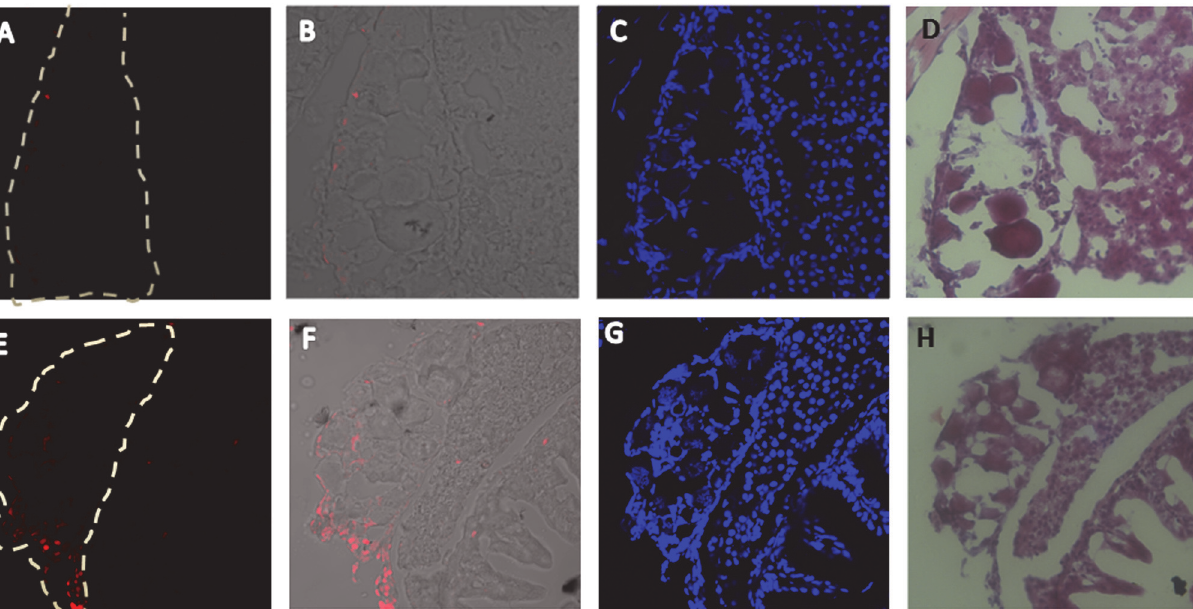
Fig 5. Induced cell death in transition gonads of the dnd :NTR-EGFP transgenic fish via MTZ treatments. The MTZ-induced cell death were evaluated by an in situ cell death assay in the transition gonads of the dnd :NTR-EGFP transgenic fish at 26 dpf stage after 1 week MTZ treatment. Transgenic fish at 18 dpf were treated with 5 mM MTZ/0.2% DMSO or 0.2% DMSO solution for 1 week. The fish were cryosectioned at 6 μ m for in situ TUNEL assay. A-D) transition gonad after MTZ treatments with apoptosis signals under fluorescent microscope (red fluorescence, A), merge images under fluorescent microscope and white light microscope (B), DAPI staining (C), HE staining (D); E-H) transition gonad in control groups with apoptosis signals under fluorescent microscope (red fluorescence, E), merge images under fluorescent microscope and white light microscope (F), DAPI staining (G), HE staining (H); The white frame indicates the gonad position.